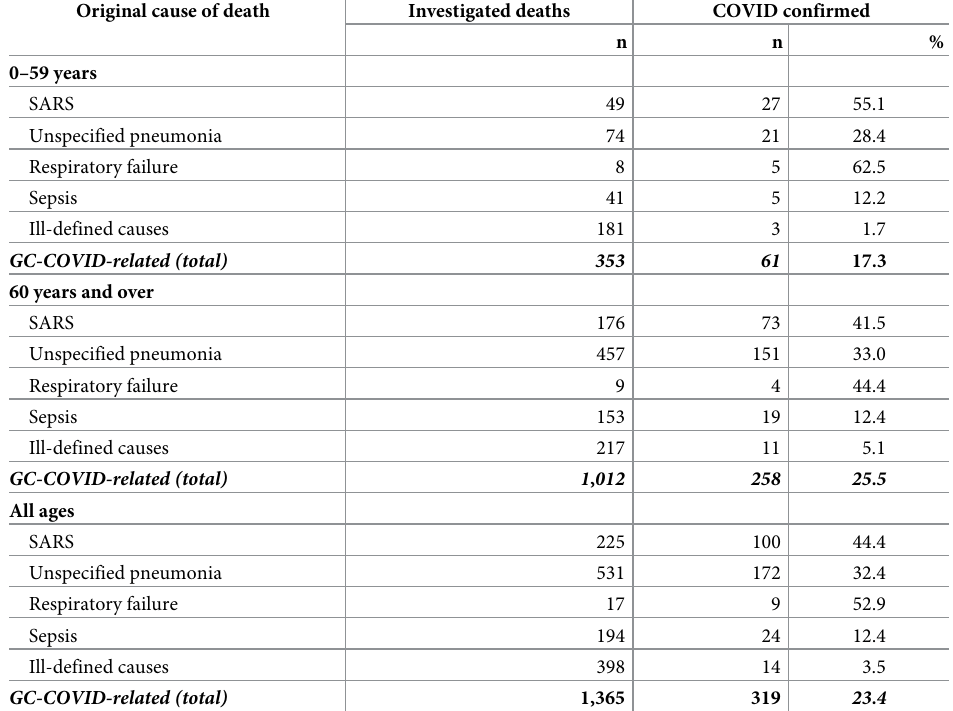
Table 3. Deaths from COVID-19 detected after investigation in selected municipalities according to original cause of death and age-group. Brazil, February to June